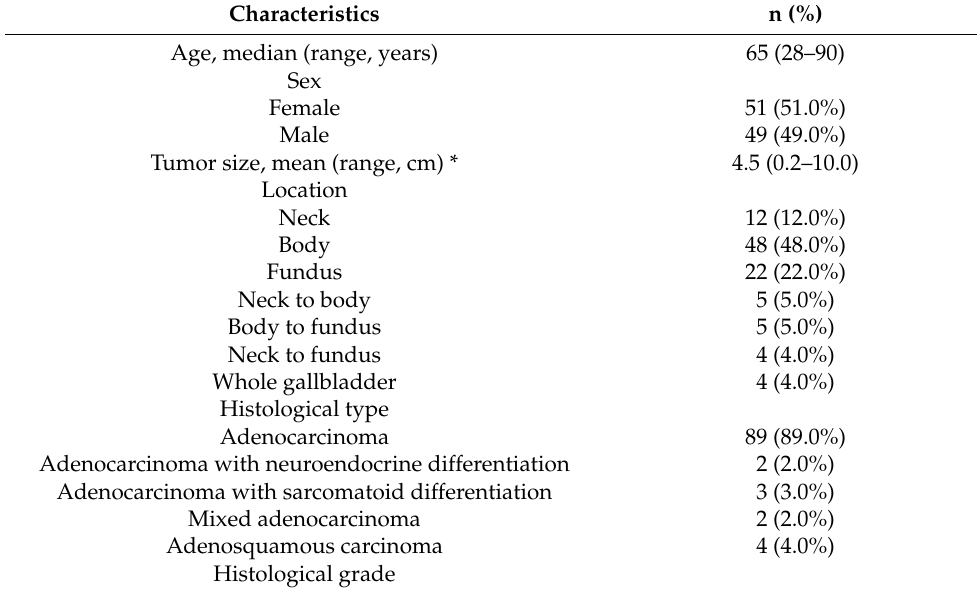
Table 1. Baseline characteristics of patients with gallbladder cancer (n =